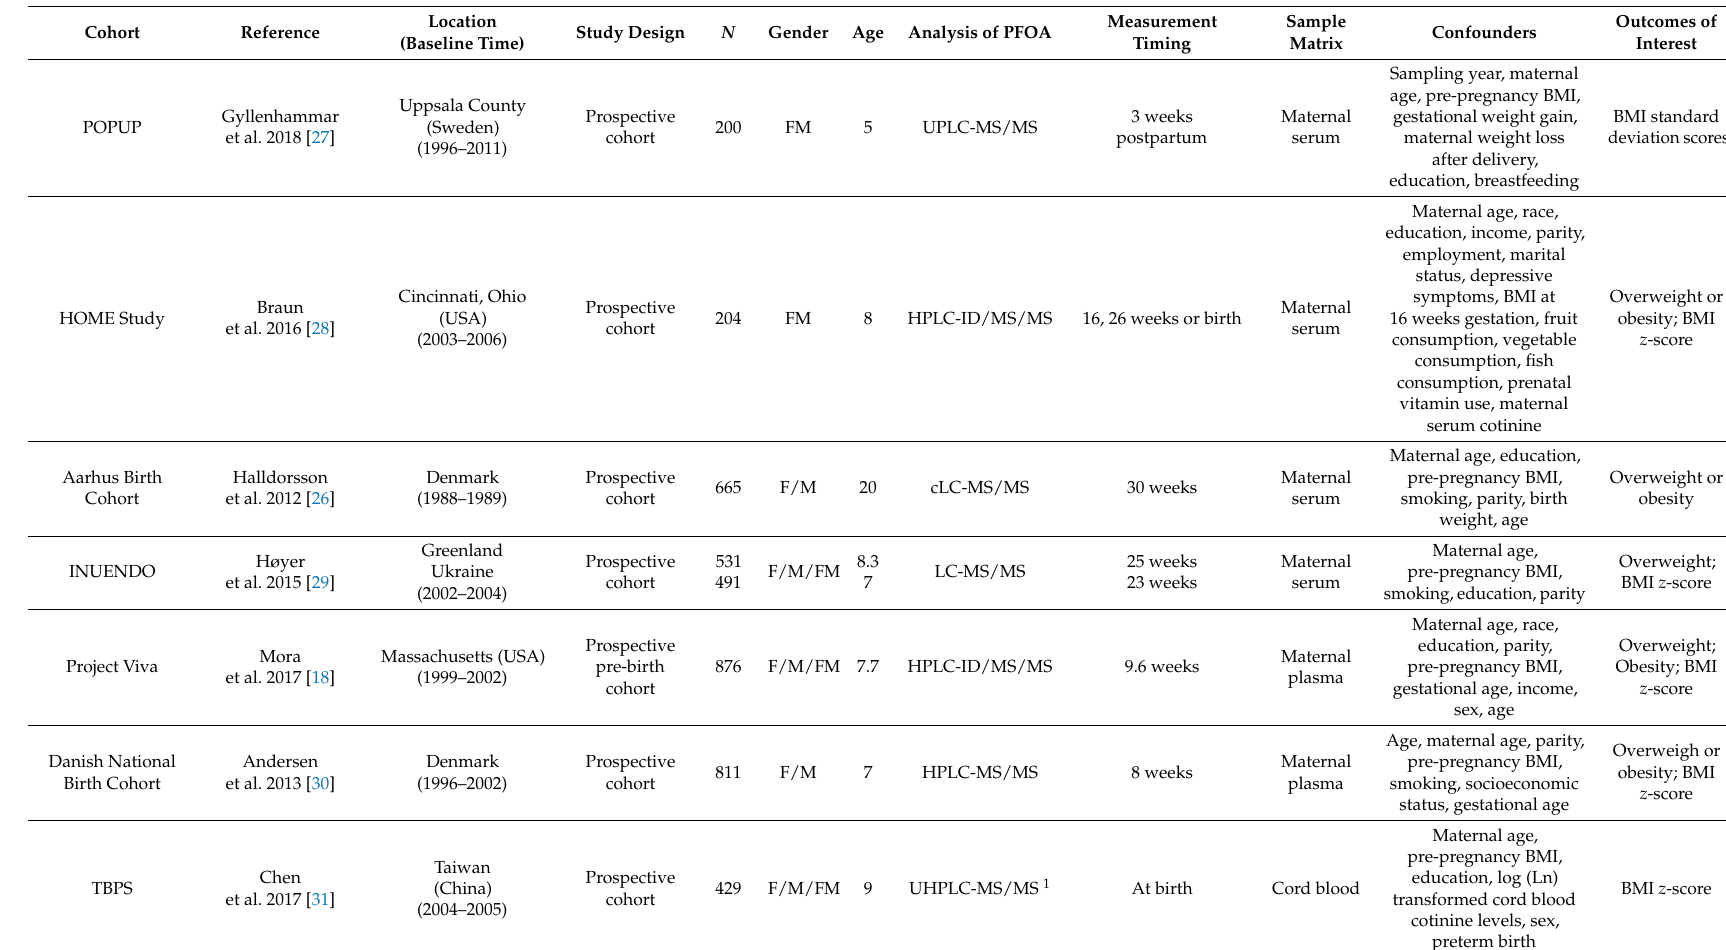
Table 1. Characteristics of prospective studies on the association between exposure to perfluorooctanoic acid (PFOA) in early life and child